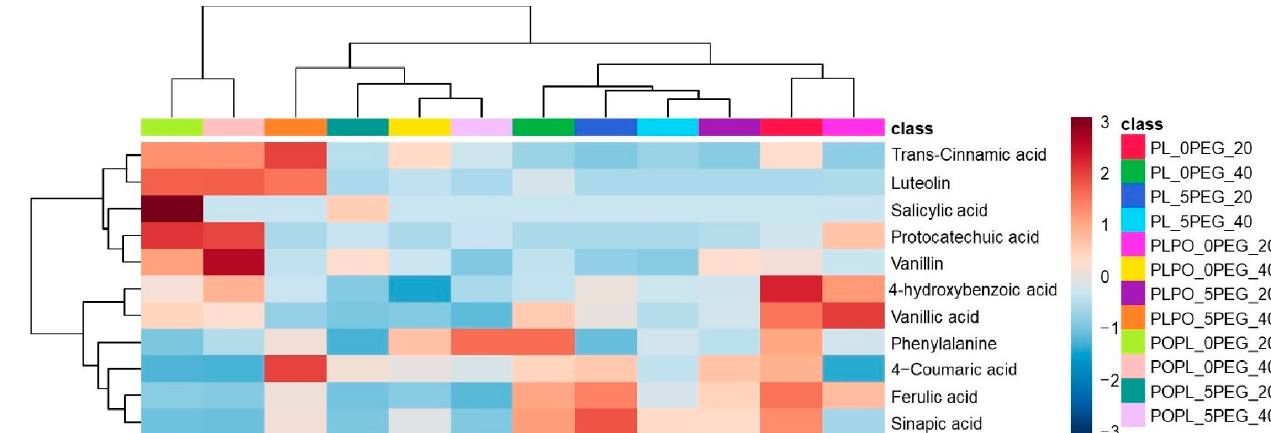
Figure 6. Hierarchical ordering heatmap of phenolic compounds identified by targeted metabolomics as result of exposure of vanilla seedlings to 20 and 40 days of PEG ‐ induced water stress. The heatmap was generated using Pearson and Ward for distance measure and clustering algorithm, respectively. PL: Vanilla planifolia , PLPO: V. planifolia × V. pompona , POPL: V. pompona × V. planifolia , 0 PEG: hydration status (control group, − 0.08 mPa), 5 PEG: hydric stress ( − 0.49 mPa), 20:20 days of water stress exposure, and 40:40 days of water stress exposure. Complementary information about the phenolic compounds is shown in Table S7.